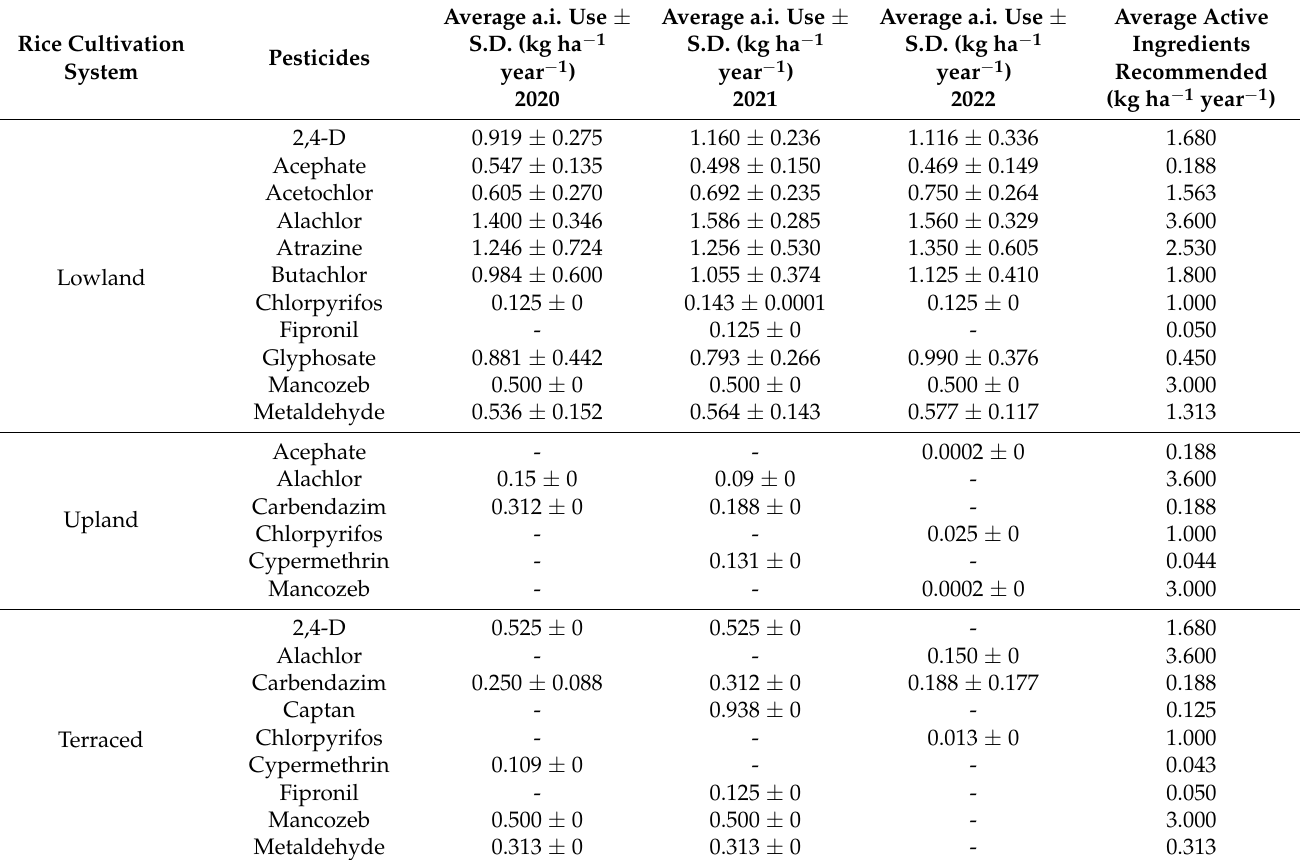
Table 5. Type and amount of pesticide used by farmers in each